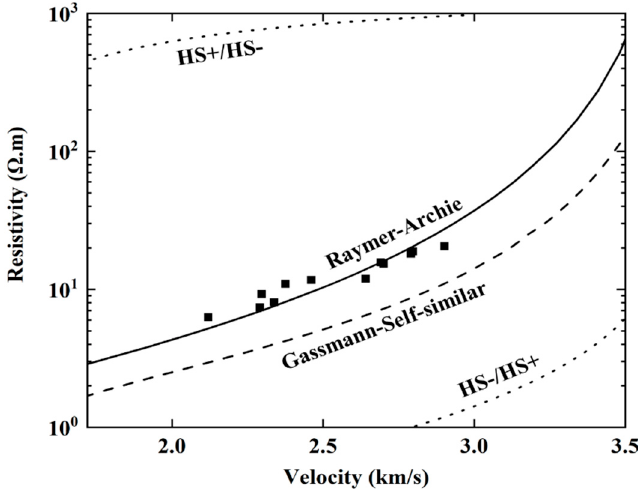
Figure 16. Different models of the relationship between the P ‐ wave velocity and resistivity. Figure 16. Di ff erent models of the relationship between the P-wave velocity and